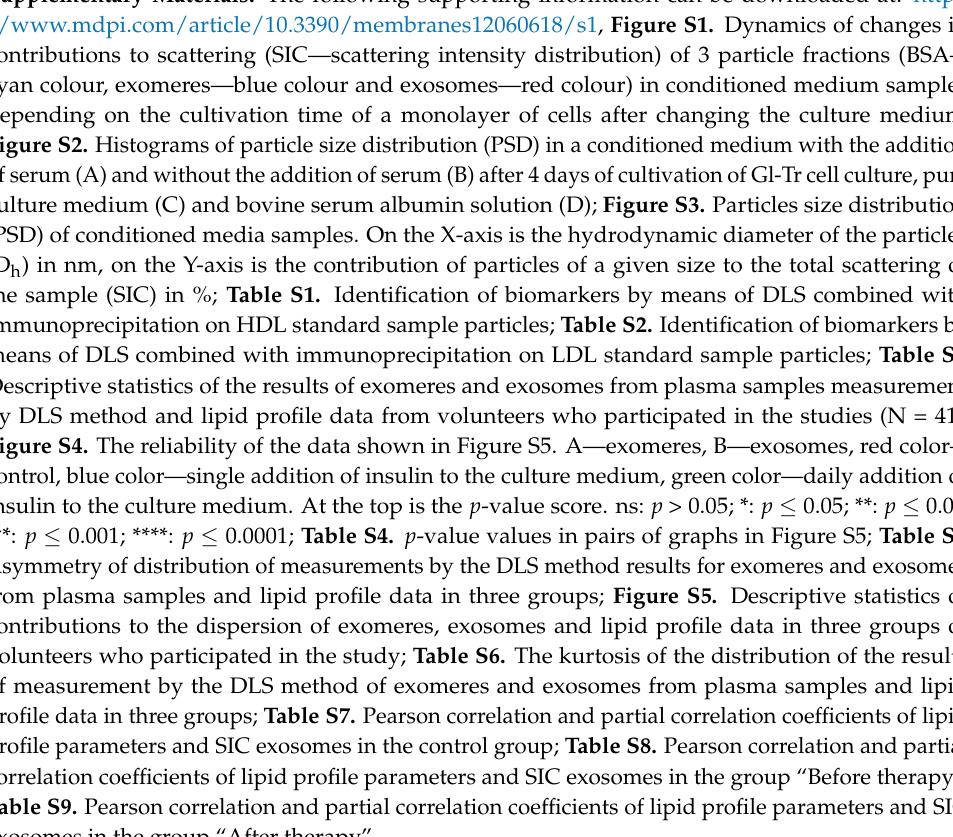
Table S9. Pearson correlation and partial correlation coefficients of lipid profile parameters and SIC exosomes in the group “After